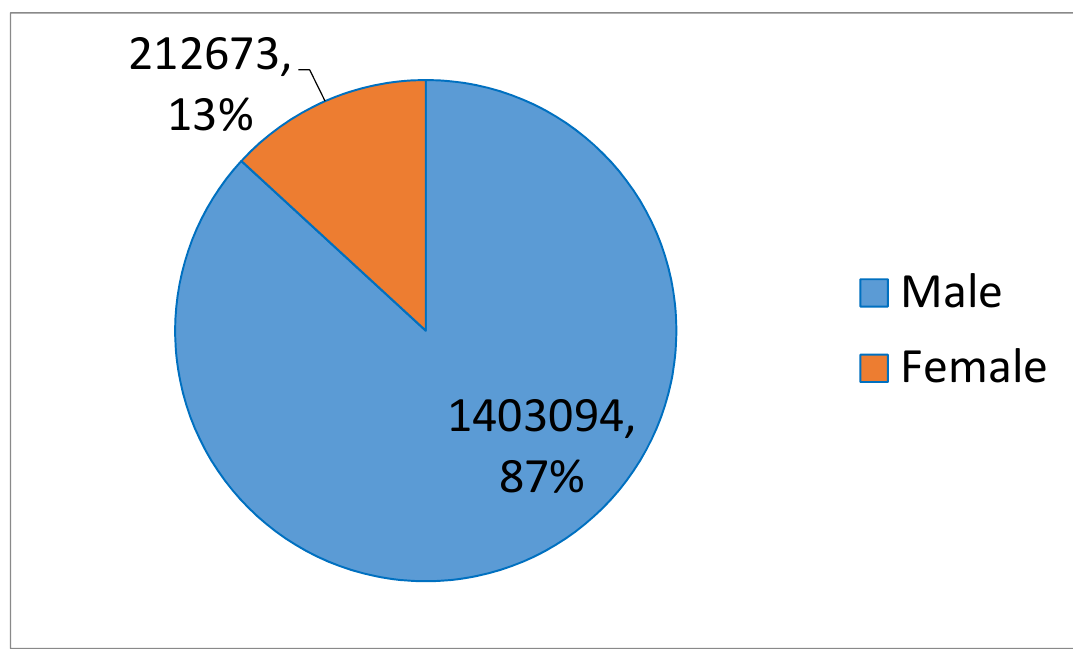
Figure 1. Words per sex of author.